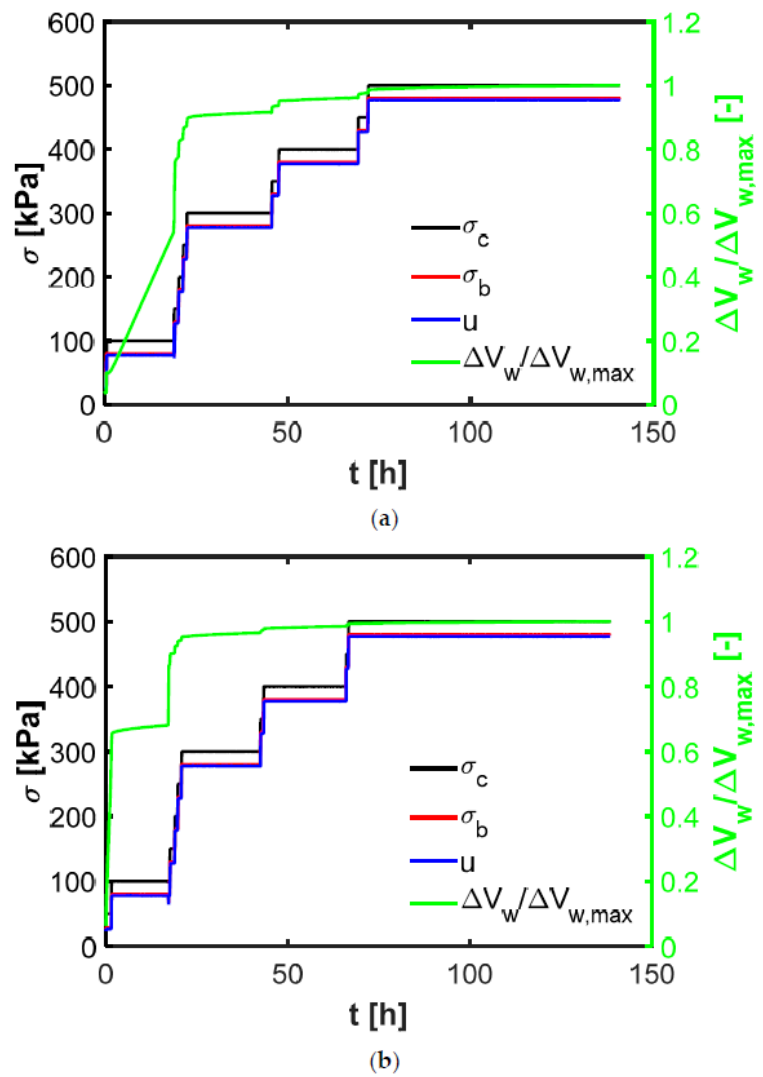
Figure 7. Room temperature saturation phase time plots of: ( a ) oM; ( b ) mM.